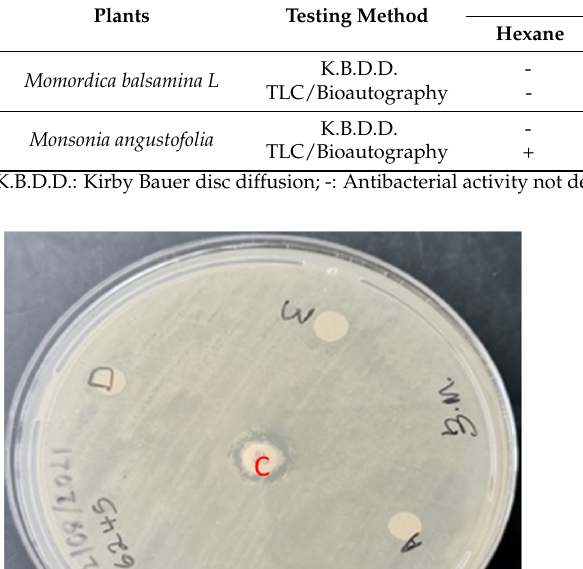
Table 1. Antibacterial activities of plant extract against A. baumannii .